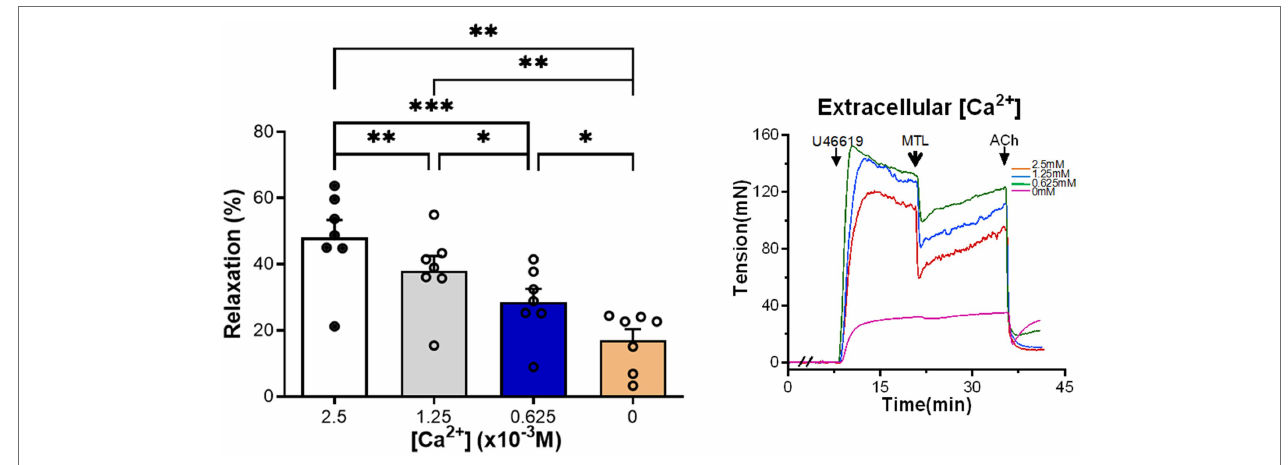
FIGURE 6 | Role of extracellular [Ca 2+ ] on motilin-induced vasorelaxation. The Krebs solutions containing different Ca 2+ concentrations decreased motilin-induced LGA relaxation in a concentration-dependent manner. Data are means ± SEM ( n = 7). * p < 0.05; ** p < 0.01; and *** p < 0.001 by one-way ANOVA. In representative traces, the double slash (//) indicates pretreatment with different Ca 2+ concentrations before incubation with U46619. The arrows indicate the time of drug administration. ACh, acetylcholine; ANOVA, analysis of variance; LGA, left gastric artery; MTL, motilin; SEM, standard error of the mean; and U46619, thromboxane A 2 receptor agonist.